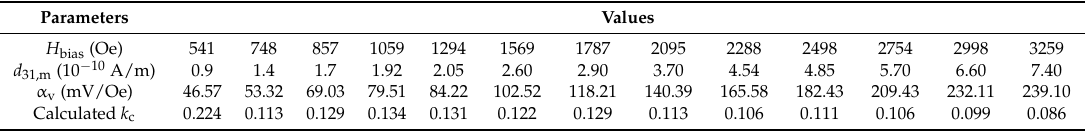
Figure 10. The measured data and surface fitting result in H bias - n - α v three-dimensional space for samples No. 1–No. 11. The blue scattered points represent the measured data under 500 g pre-mechanical load and the surface represents the transverse ME voltage coefficient corresponds to k c = 0.11. Table 4. The calculated interface coupling factor k c of sample No. 6.